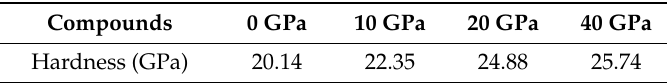
Table 3. Calculated Vickers hardness of TcP 4 at different